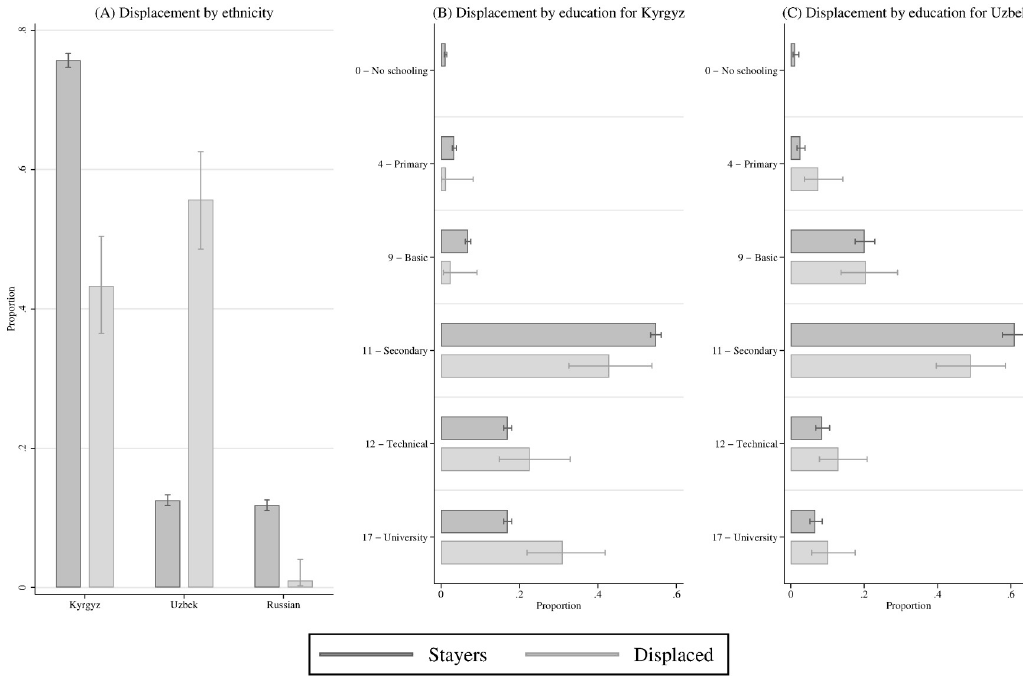
Fig 3. Education by ethnicity and displacement. Notes: Cross-tabulations of education, ethnicity and displacement status for the three largest ethnic groups. The left pane shows estimated proportions of ethnicities for the displaced and non-displaced. The middle pane shows estimated proportions of education levels for displaced and non-displaced only for ethnic Kyrgyz. The right pane shows estimated proportions of education levels for displaced and non-displaced only for ethnic Kyrgyz. Error bars indicate 95% confidence intervals. (Source: Life in Kyrgyzstan (LiK) study 2010